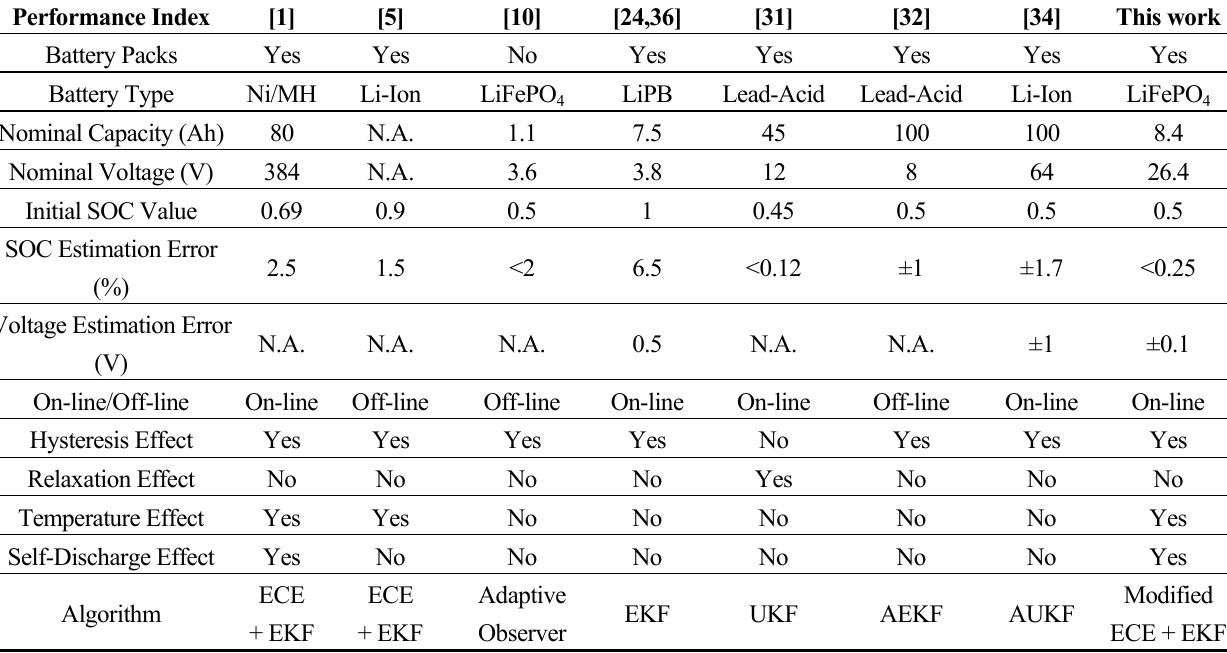
Table 5. Comparison with SOC Estimation Algorithm in the